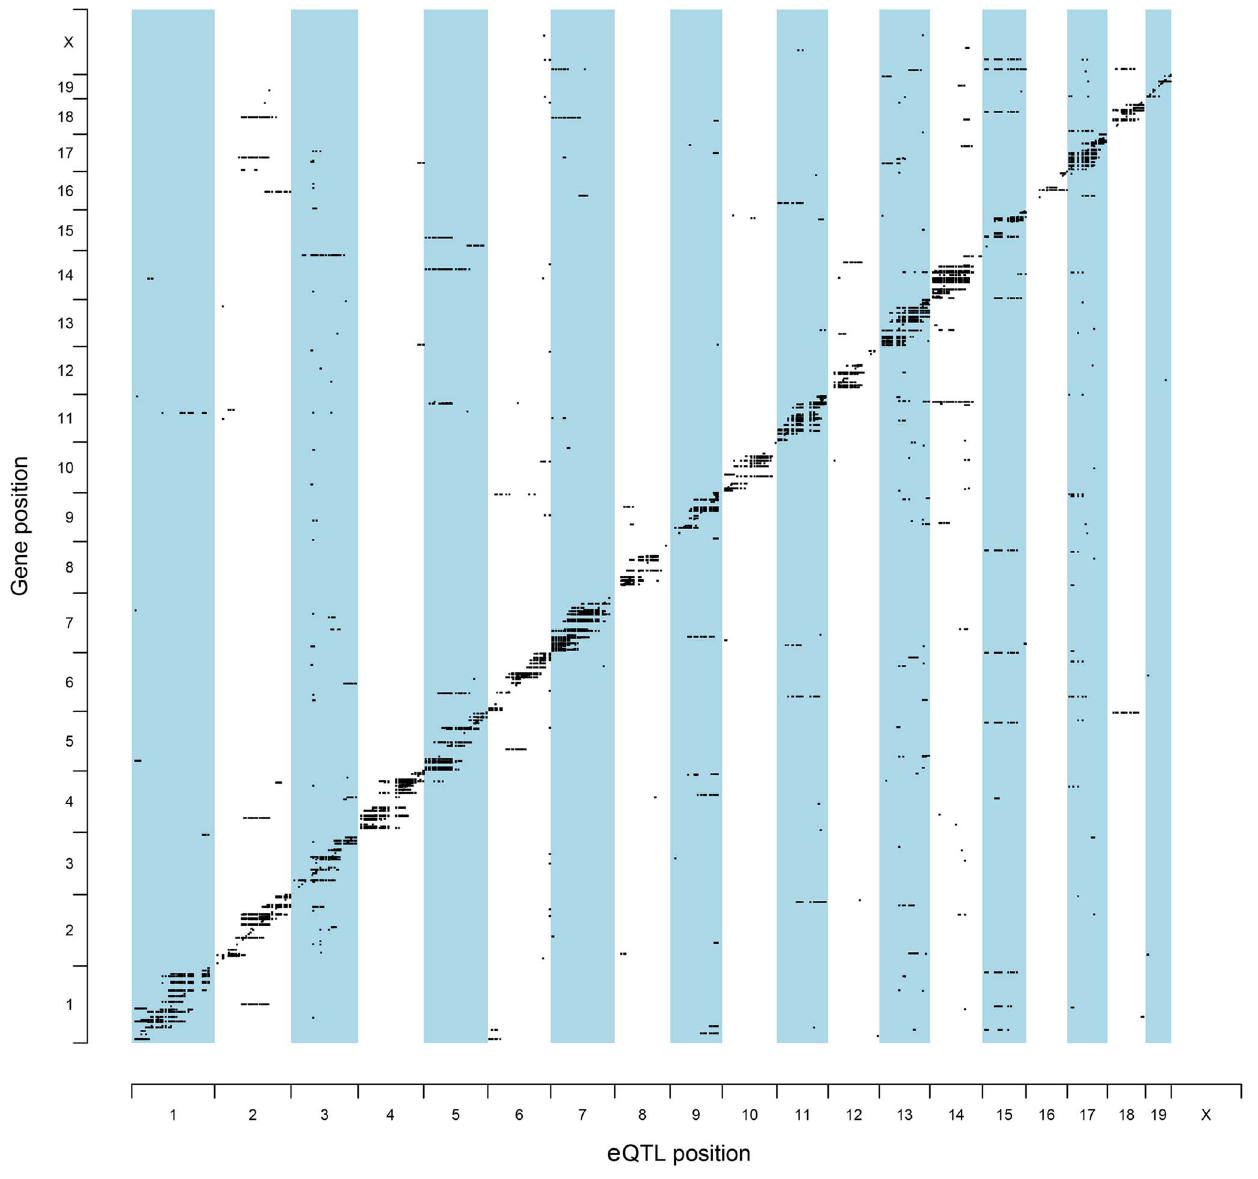
Figure 2. Genomic locations of eQTLs relative to their cognate transcript. The chromosomal locations for all statistically significant eQTLs identified in (TRAMP 6 NOD/ShiLtJ) F2 tumors (FDR , 0.05) are illustrated relative to their associated transcript. as proximal eQTLs (Table S2) and 8,656 as distal and/or trans- eQTLs (Table S3). However, of the 8,656 distal and/or trans-